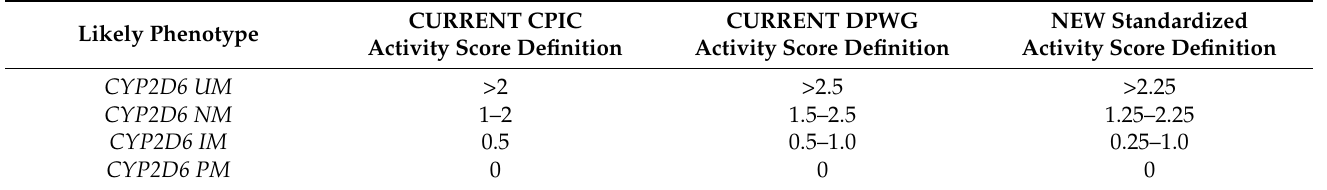
Table 1. Adapted final consensus CYP2D6 genotype to phenotype table. Combining the previous CPIC and DPWG guidelines and adding new pharmacogenetic insights [38]. Abbreviations: CYP2D6: Cytochrome P450 2D6, UM: ultra-rapid metabolizer, NM: normal or extensive metabolizer, IM: intermediate metabolizer, PM: poor metabolizer, CPIC: Clinical Pharmacogenetic Implementation Consortium, DPWG: Dutch Pharmacogenetics Working